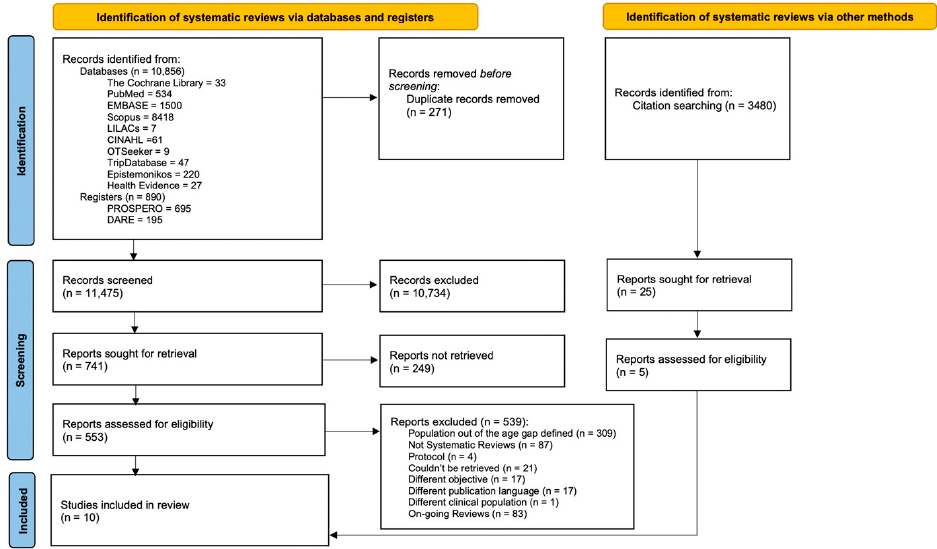
Figure 1. Flow chart of the included systematic reviews, following PRISMA guidelines.